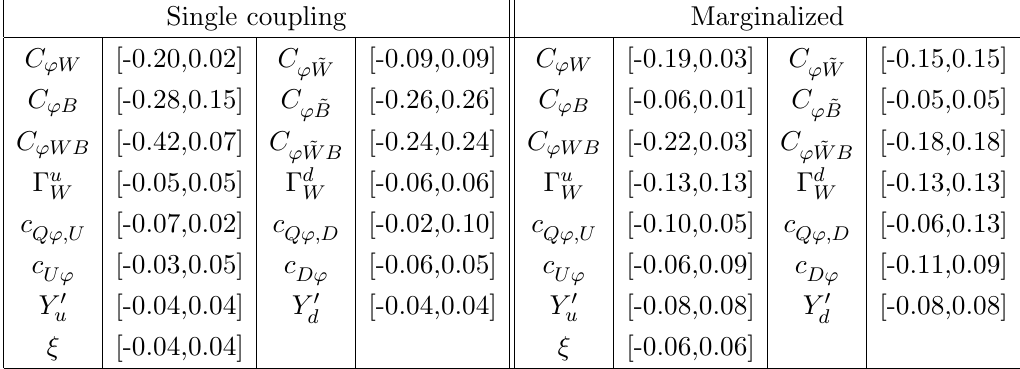
Table 4 . 90% CL level bounds on the coe(cid:14)cients of e(cid:11)ective operators that contribute to WH and ZH production. For operators involving quarks, we turned on couplings to the u and d quark. The table on the left shows the bounds obtained assuming that a single operator is turned on at a scale (cid:3) = 1 TeV. On the right, marginalized bounds, from WH and ZH production and